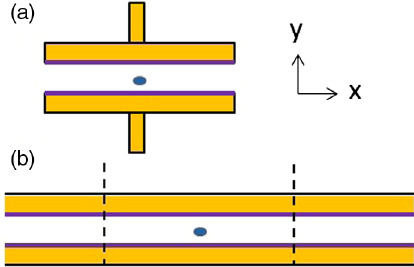
FIG. 2. Sketch of a vertical set of dechirper jaws seen end on: (a) in the real geometry the jaws have a finite width w ; (b) in the model used in the calculation, the width is infinite, but the loss integration is performed only over a width w (represented by the distance between the dashed lines). The purple lines represent the corrugated surfaces; the blue ellipses, the exciting particle ’ s transverse